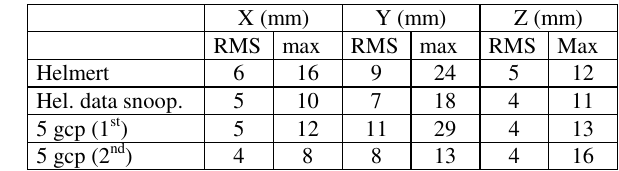
Table 4. Myson, manual orientation: statistics of the discrepancies with the two